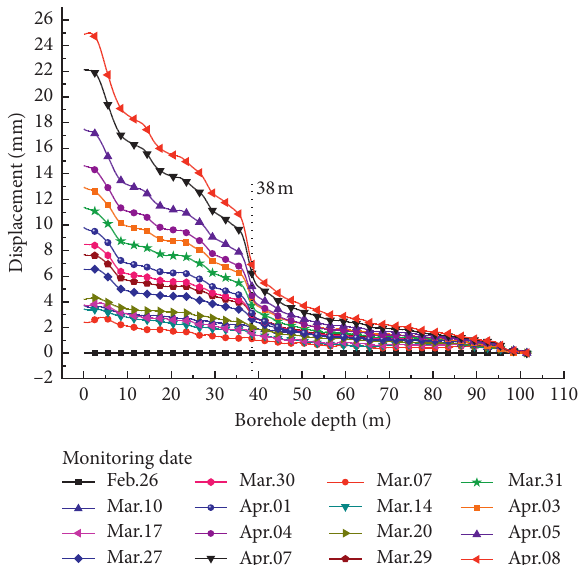
Figure 6: Distribution curve of displacement along the borehole axial